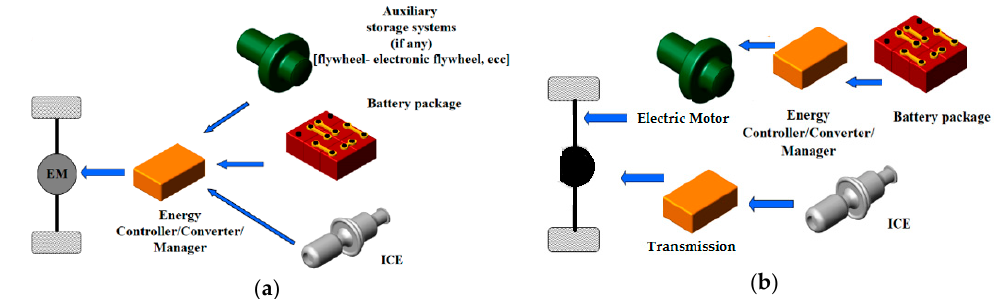
Figure 1. ( a ) Series Hybrid Configuration; ( b ) Parallel Hybrid Configuration.